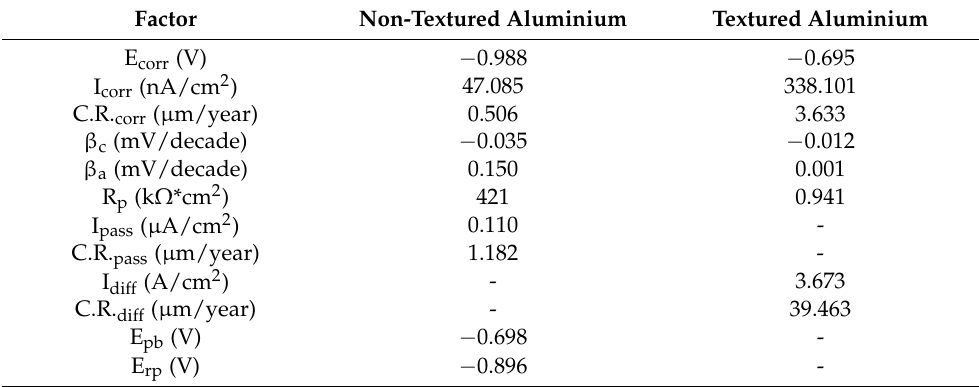
Table 4. PPC factors of the non-textured and textured samples in 0.6 M NaCl. Factor Non-Textured Aluminium Textured